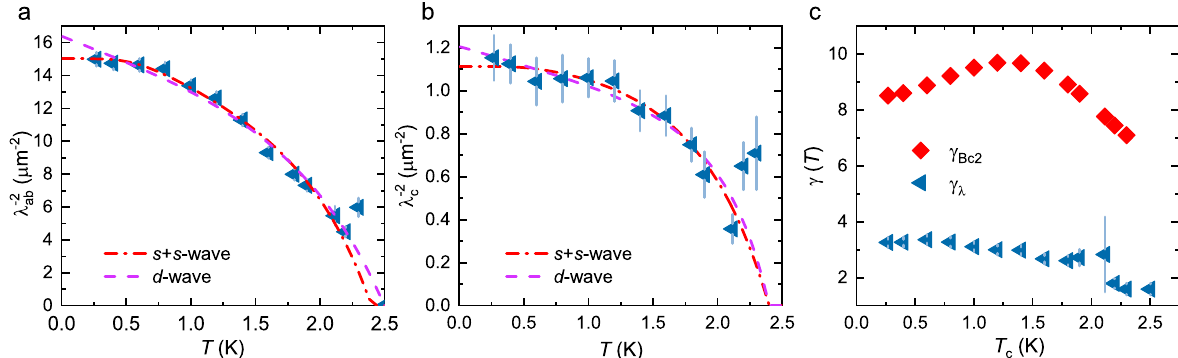
Fig. 3 Temperature dependence of London penetration depth and anisotropy parameter. a and b Temperature variations of the in-plane and out-of-plane component of the inverse squared magnetic penetration depths, λ (cid:3) 2 wave, and a nodal d -wave model, as described by the phenomenological α -model. c Magnetic penetration depth anisotropy ( γ λ ) and upper